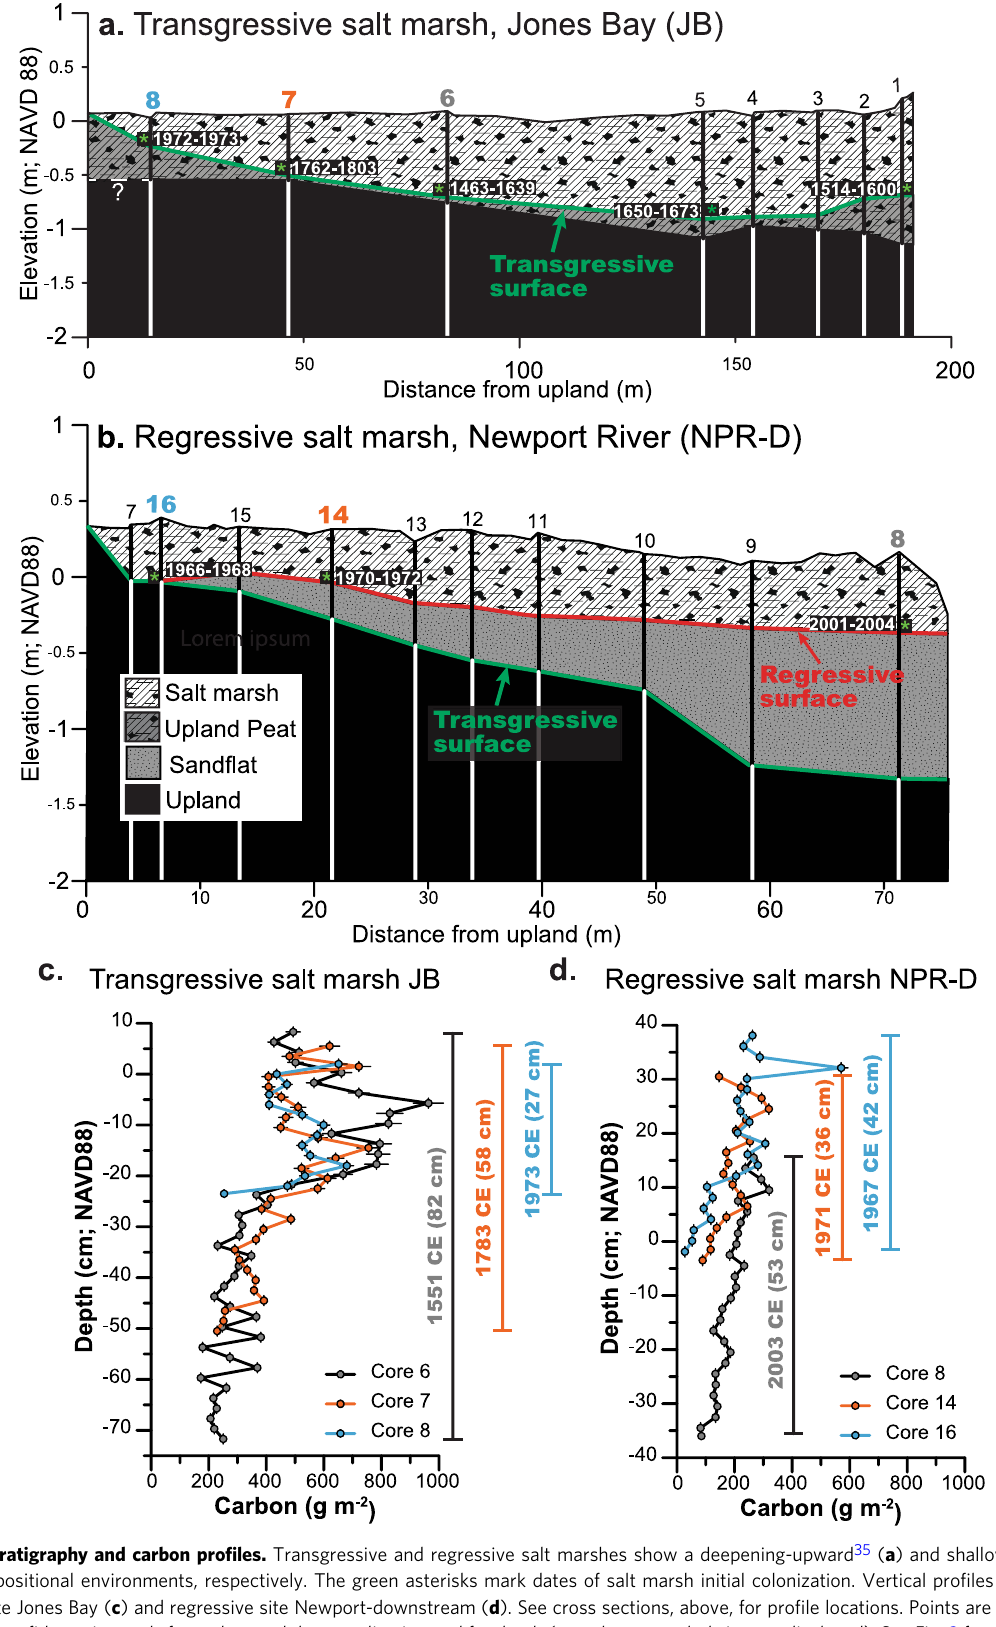
Fig. 3 Marsh stratigraphy and carbon pro fi les. Transgressive and regressive salt marshes show a deepening-upward 35 ( a ) and shallowing-upward ( b ) sequence of depositional environments, respectively. The green asterisks mark dates of salt marsh initial colonization. Vertical pro fi les of carbon at transgressive site Jones Bay ( c ) and regressive site Newport-downstream ( d ). See cross sections, above, for pro fi le locations. Points are plotted with bars displaying 95% con fi dence intervals for carbon and the sampling interval for depth (error bars <symbol size not displayed). See Fig. 2 for transect locations and Supplementary Data 1 for additional information on dates and